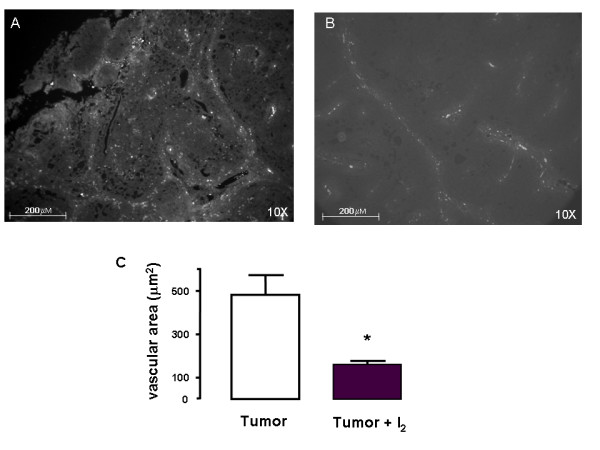
Vascular area. Immunofluorescence blood vessels in tumors from control (A) and I2-supplemented rats (B). Vessel area was calculated as the total field area positively stained for the vascular marker (μm2). C, quantification. Differences between experimental groups were analyzed using an unpaired t test. *indicates significant difference from the control (p < 0.05)